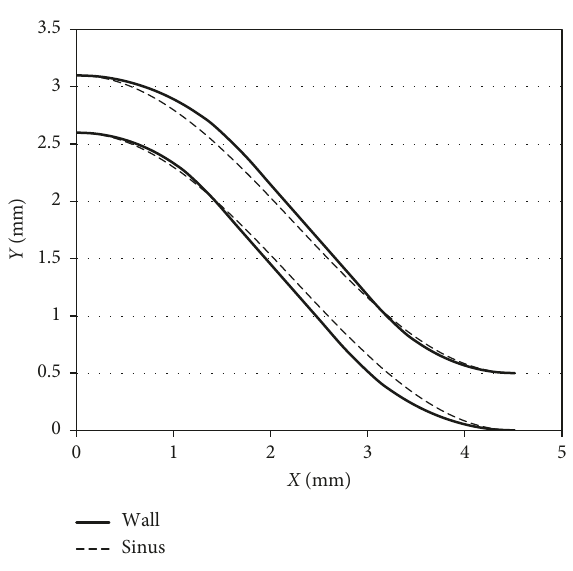
Figure 5: Corrugation profile of a plate.